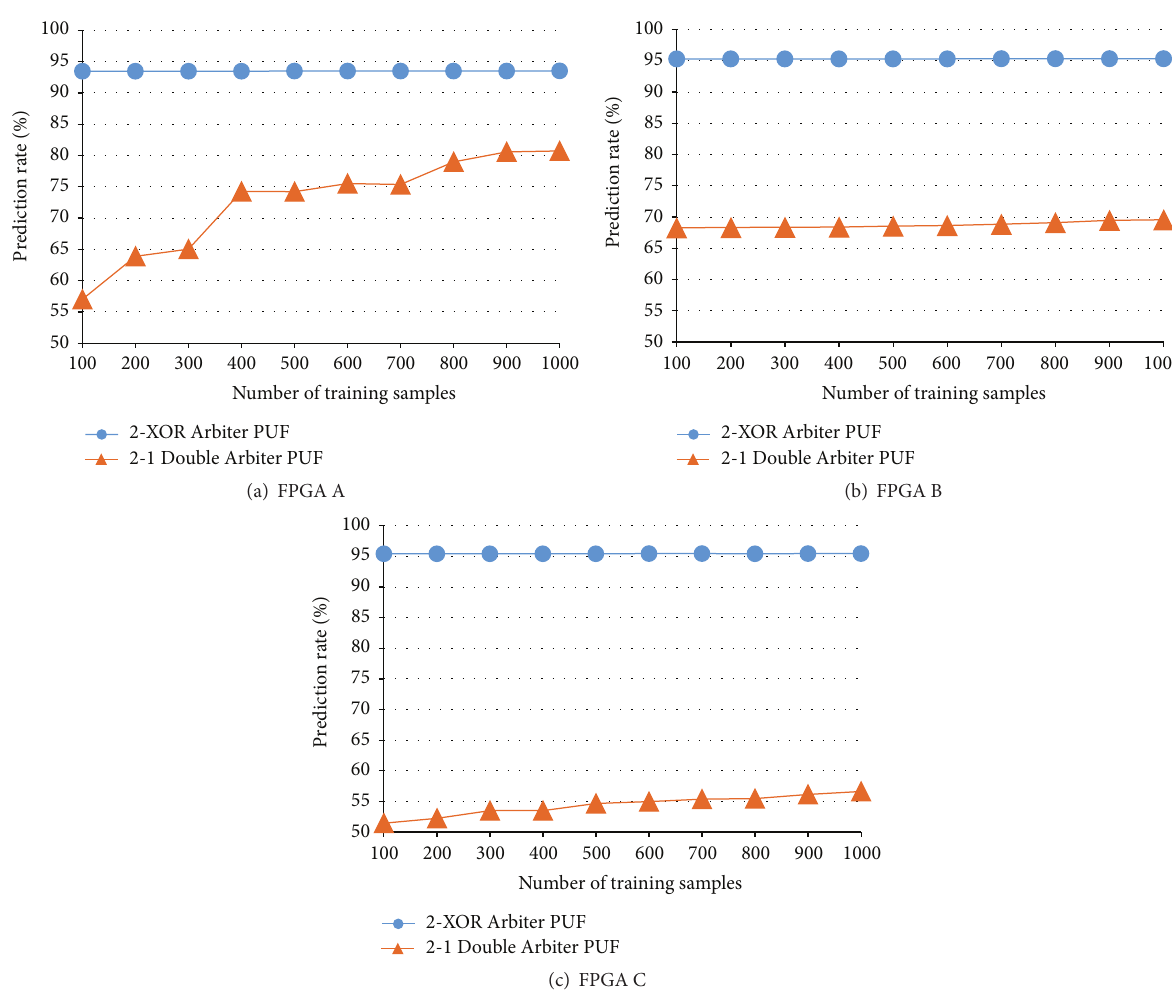
Figure 11: Prediction rates of 2-XOR Arbiter PUF and 2-1 Double Arbiter